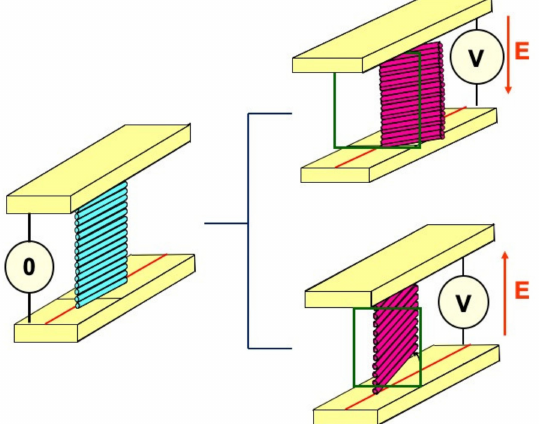
Figure 1. Principle of a Smectic Single Domain-Liquid Crystal (SSD-LC) drive mode. The stacked liquid crystal molecules swing either clockwise or counterclockwise, dependent on the applied electric field